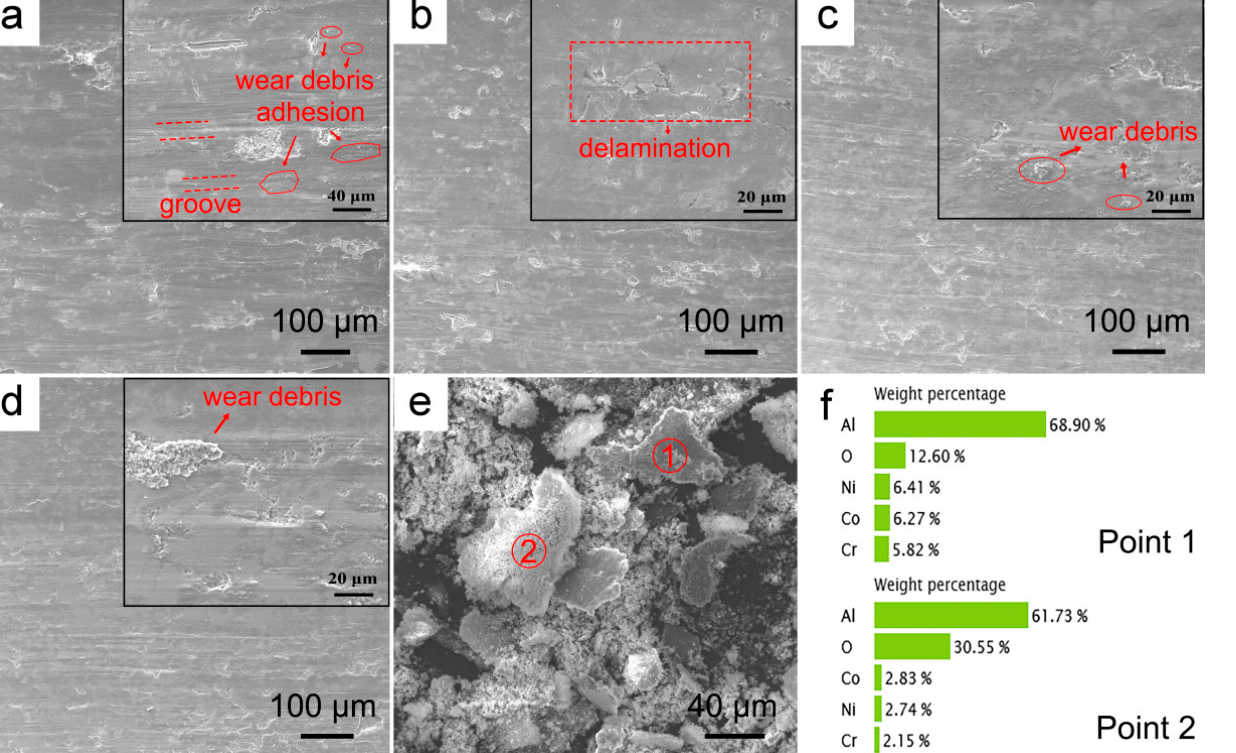
Figure 10. SEM observations of the composites with the different CrCoNi content after friction. ( a ) 5 wt.% CrCoNi; ( b ) 10 wt.% CrCoNi; ( c )15 wt.% CrCoNi; ( d ) 20 wt.% CrCoNi; ( e ) wear debris of the 10 wt.% CrCoNi/Al composite; ( f ) the EDS results recorded from point 1 and point 2 are marked in ( e